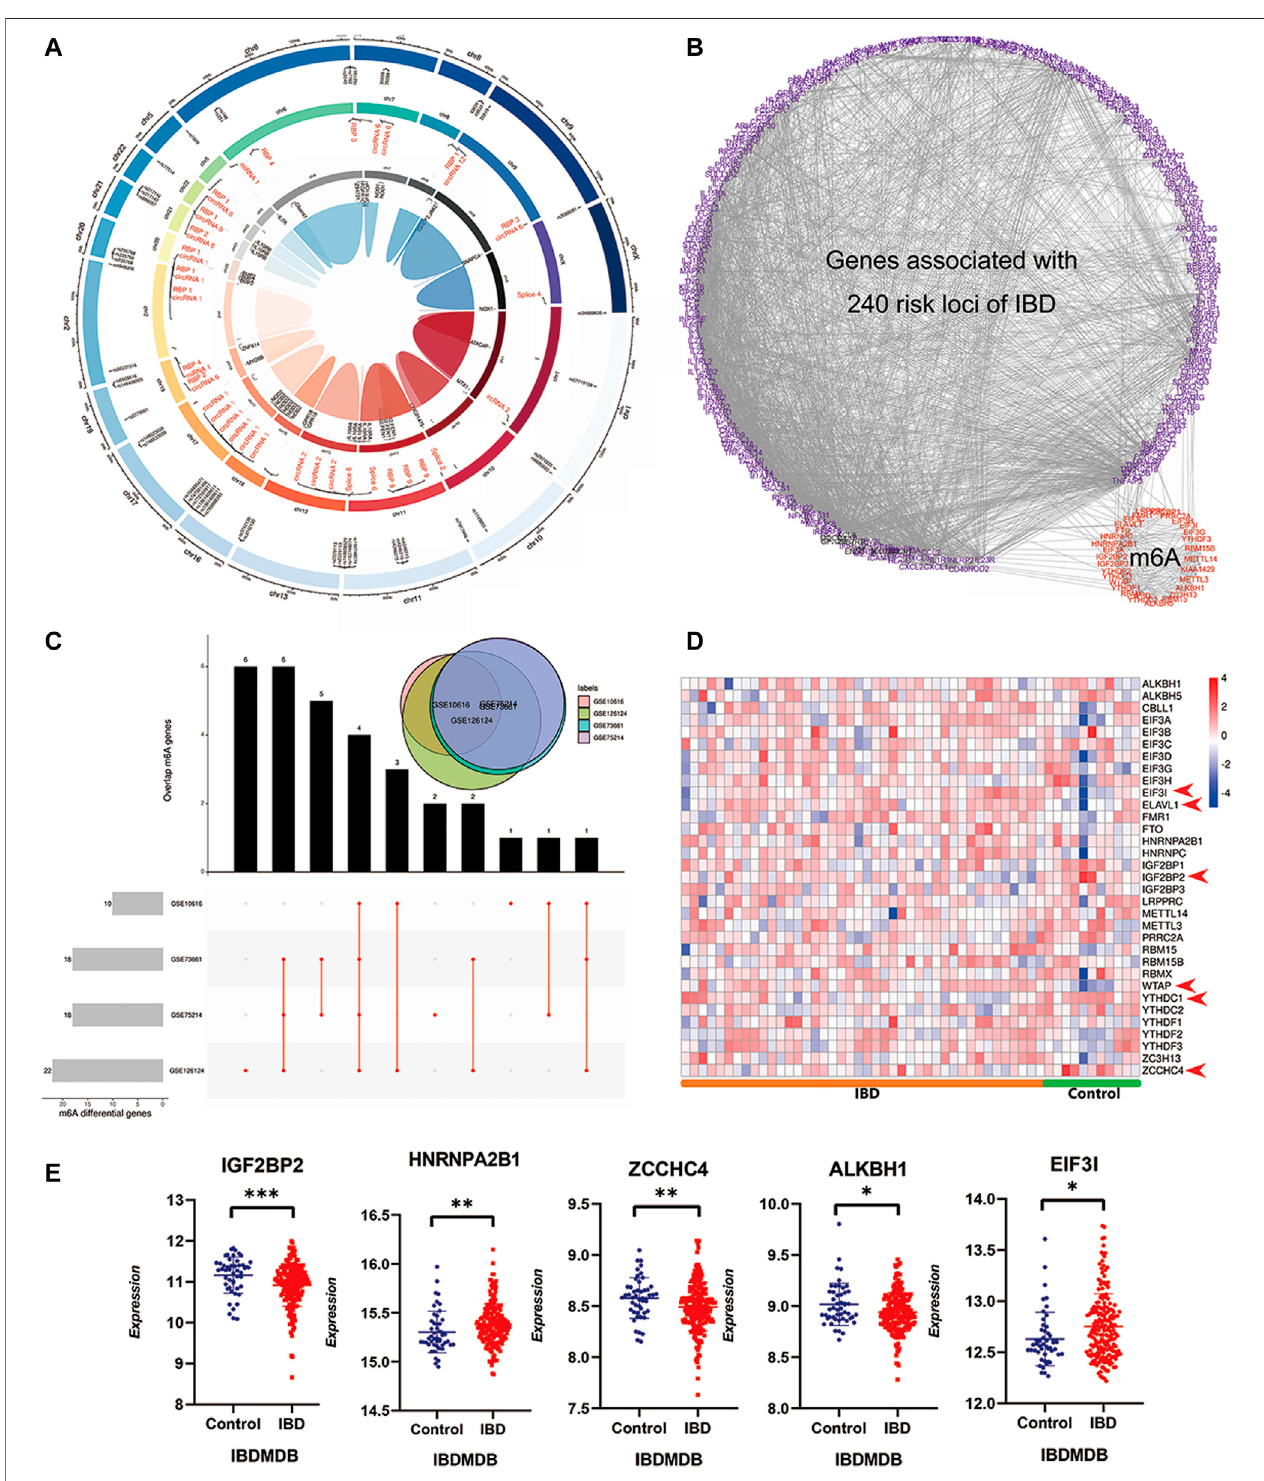
FIGURE 2 | A widespread interaction and participation of m6A modi fi cations in IBD. (A) is the Circos diagram of known m6A modi fi cations in IBD associated risk SNPs based m6A sequencing. The outer circle indicates the positions of m6A modi fi ed IBD associated risk SNPs in chromosome, the middle circle is transcriptome regulation ofrisk SNPs, theinner circle is the riskgene name. (B) isthe interactionnetworkof 240known IBD riskgenes and m6A reader, writer and eraser genes. (C) is the UpSet diagram of differential m6A regulators in four independent discovery IBD cohorts. The upper right venn displays the overlaps of differential genes in four cohorts together. (D) is the heatmap of m6A reader, writer and eraser in validatory IBDMDB cohort. (E) is the expressing pro fi le of top differential m6A regulators in the validatory IBDMDB cohort (t test, p < 0.05).